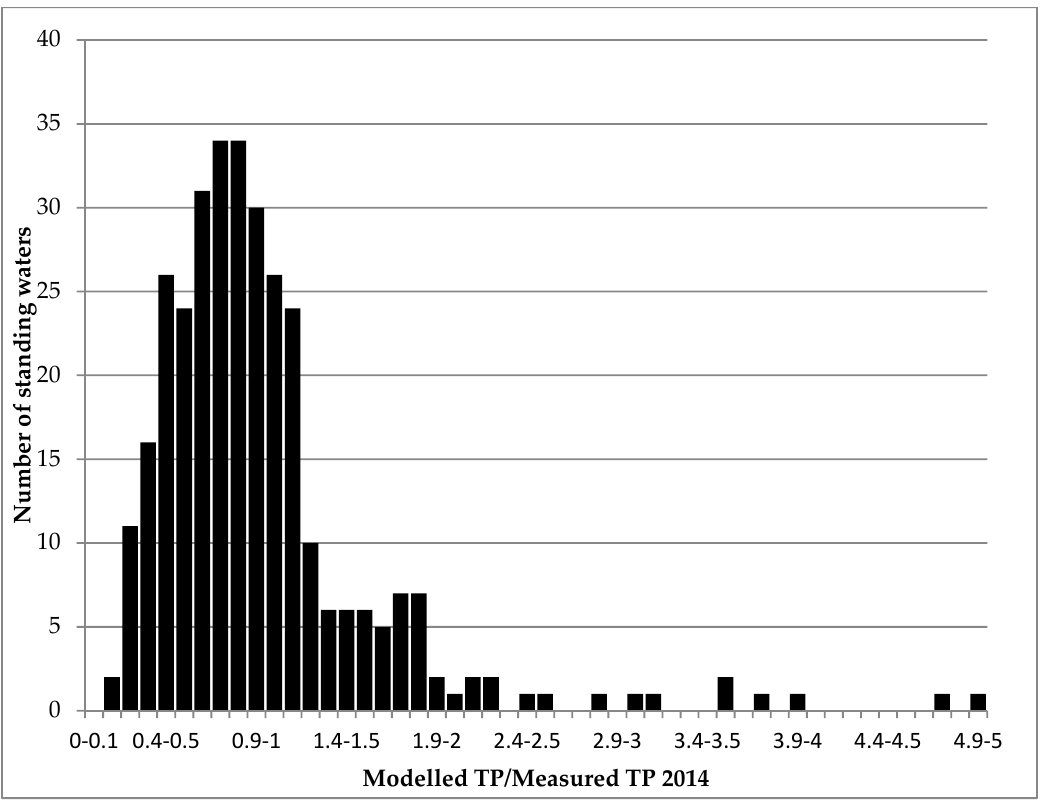
Figure 3. Frequency distribution of the ratio between TP concentrations derived from PLUS+ and those measured in 323 Scottish catchments (2014).